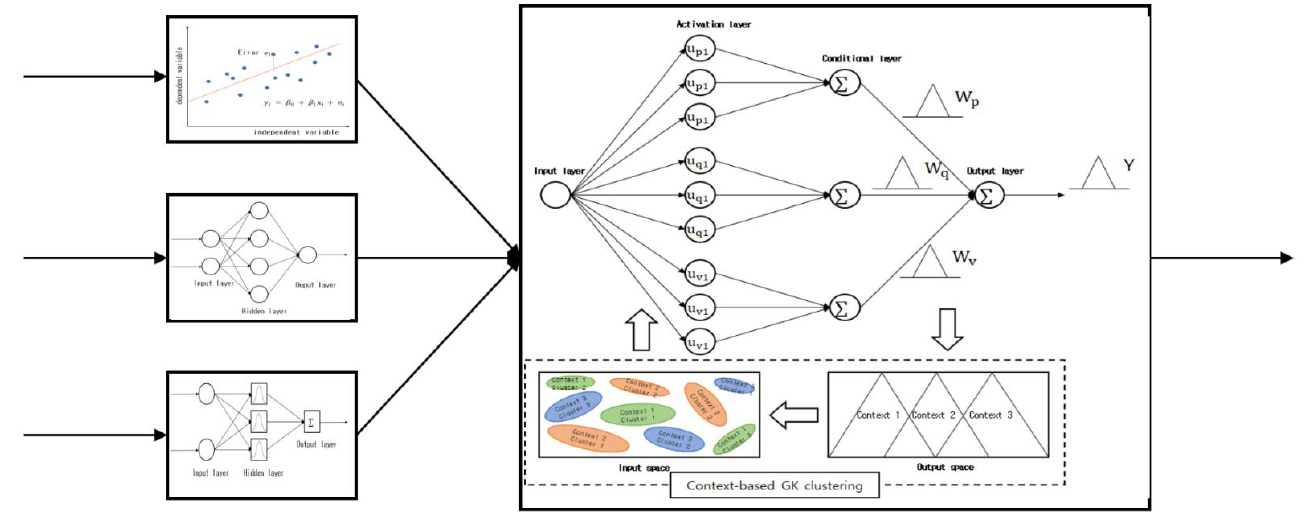
Figure 15. Structure of a CGK granular model with an aggregated structure.